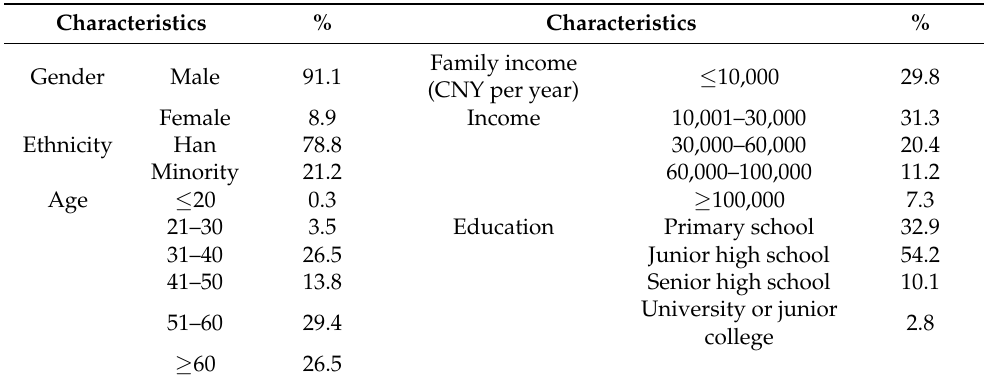
Table 2. Demographic profile of